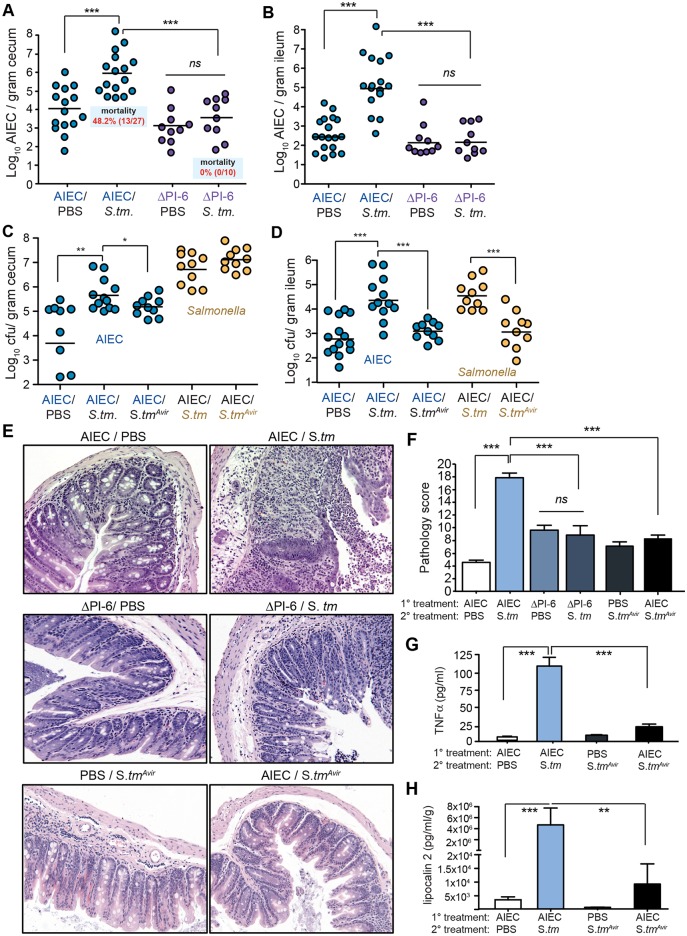
Resistance to host defense peptides is required for AIEC expansion in the inflamed gut and immunopathology.129e mice were colonized with wild type AIEC or the peptide-sensitive ΔPI-6 mutant and then infected with Salmonella. Survival was assessed over 35 days and the tissue burden of AIEC was determined in the cecum (A) and the ileum (B). Each point represents one animal and the data represents 3 independent experiments. ***p< 0.001 (Mann-Whitney test). 129e mice were colonized with AIEC and then infected with either wild type Salmonella or a mutant that is less proinflammatory, S.tm
avir. Tissue burden of AIEC (blue circles) and Salmonella (yellow circles) was determined in the cecum (C) and the ileum (D). Each point represents one animal and the data represents 2 independent experiments. *p<0.05; **p<0.01; ***p< 0.001 (Mann-Whitney test). (E) H&E-stained tissue samples from cecal tips are shown for the indicated infection groups. Original magnification 200x. (F) Quantification of histopathology from part E. Data are the means ± SEM of 5 mice per group from 2–3 separate experiments and 5 views per mouse. ***p<0.001 (one way ANOVA with Tukey). (G) TNFα levels determined from explanted cecal supernatants by ELISA. (H) Fecal lipocalin-2 levels determined from fecal pellets on day 5 after Salmonella infection. Data are means with SEM from 2–3 experiments. **p<0.01, ***p< 0.001 (Mann-Whitney test).